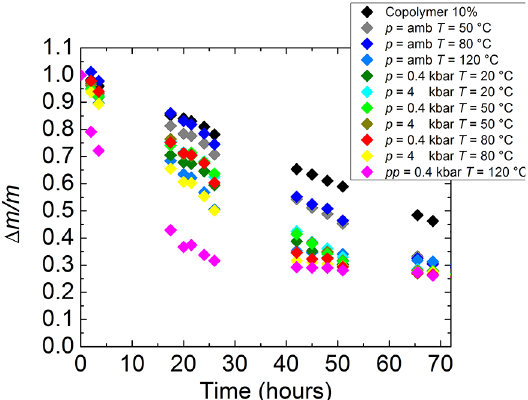
Figure 5. Time dependence of the mass variation of wet membranes due to the release of LP30.